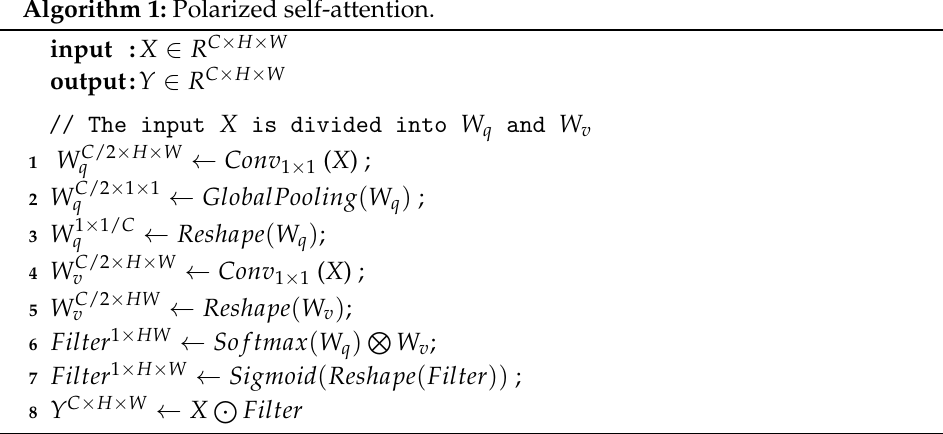
Figure 3. The whole architecture of polarized self-attention. Algorithm 1: Polarized